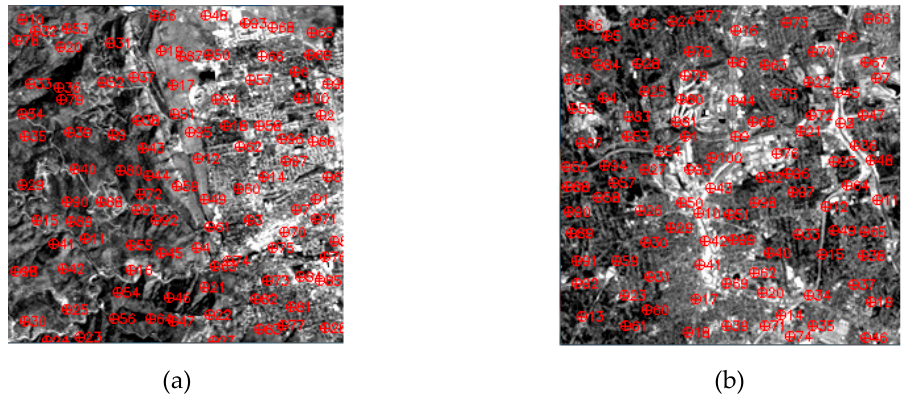
Figure 21. Check points distribution in: ( a ) the first image and ( b ) the second image. Table 3. The values of root mean square errors ( RMSE s) of the georeferenced image of the first image. Platform